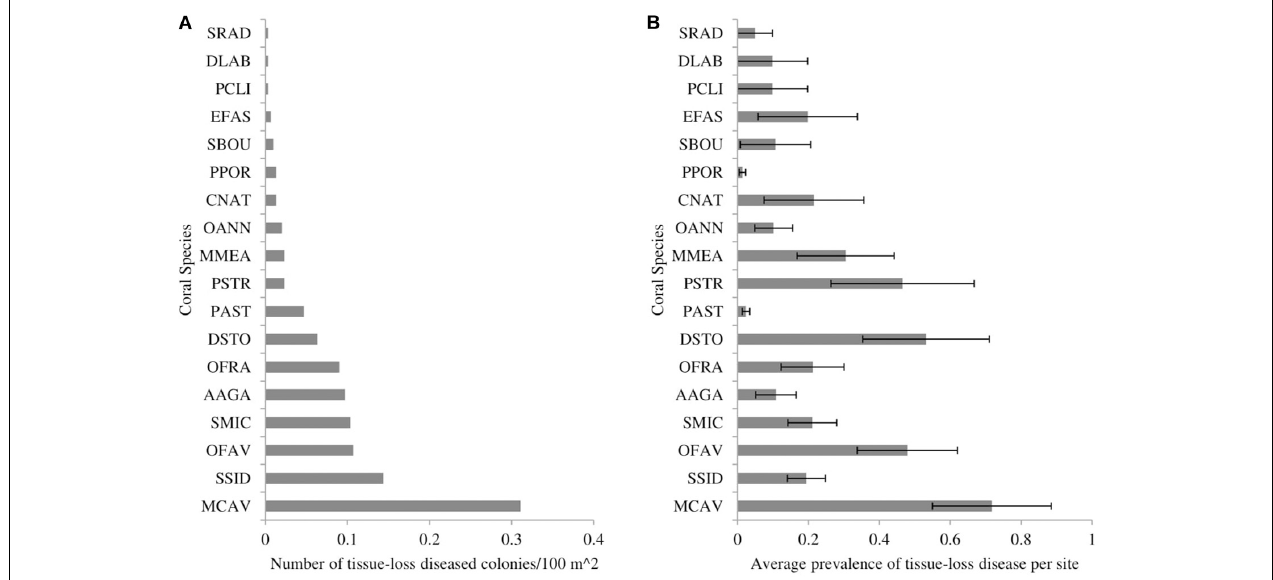
FIGURE 1 | The (A) number of coral colonies showing signs of stony-coral-tissue-loss disease per 100 m 2 of surveyed area and (B) average prevalence of stony-coral-tissue-loss disease from May 2014 to December 2017 throughout the Florida reef tract, separated by coral species. Prevalence was calculated as the number of diseased colonies per species divided by the total number of colonies per species. Error bars represent the standard error of the mean. SRAD: Siderastrea radians , DLAB: Diploria labyrinthiformes , PCLI: Pseudodiploria clivosa , EFAS: Eusmilia fastigiata , SBOU: Solenastrea bournoni , PPOR: Porites porites , CNAT: Colpophyllia natans , OANN: Orbicella annularis , MMEA: Meandrina meandrites , PSTR: Pseudodiploria strigosa , PAST: Porites astreoides , DSTO: Dichocoenia stokesii , OFRA: Orbicella franksi , AAGA: Agaricia agaricites , SMIC: Stephanocoenia michelini/intersepta , OFAV: Orbicella faveolata , SSID: Siderastrea siderea , MCAV: Montastraea cavernosa